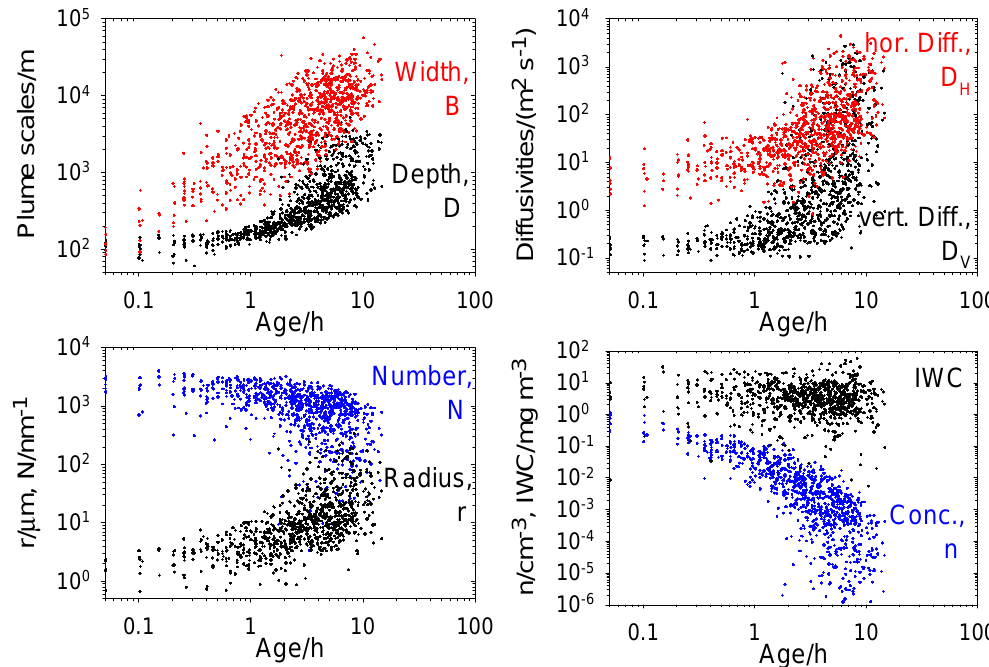
Fig. 7. Contrail properties versus contrail age in a set of contrail segments in the North Atlantic region during 6–9 June 2006. Top-left panel: Width B and depth D . Top-right: Horizontal and vertical diffusivities D H and D V . Bottom-left: Total number of ice particles per nanometer flight distance N , ice particle volume mean radius r , Bottom-right: Ice particle number concentration per volume n , and ice water mass content per volume ρI